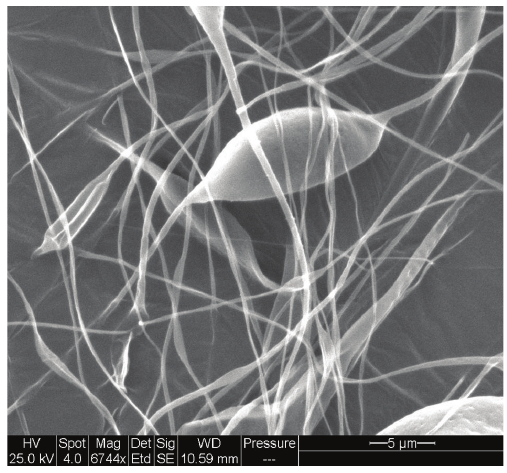
Figure 4: SEM image of 3% PFMOP nanofibers.